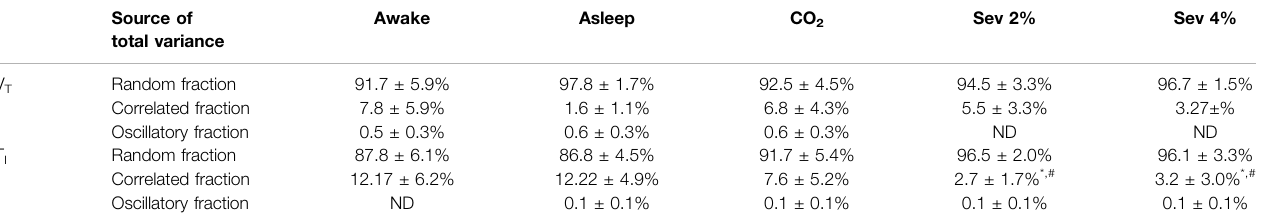
TABLE 2 | Fractions of total variance of tidal volume (V T ) and inspiratory time (T I ) attributed to random, correlated, and oscillatory components under the different protocol stages (Sev: sevo fl urane, ND: not detectable). Data are presented as mean ± 95% con fi dence interval of the mean. Source of total